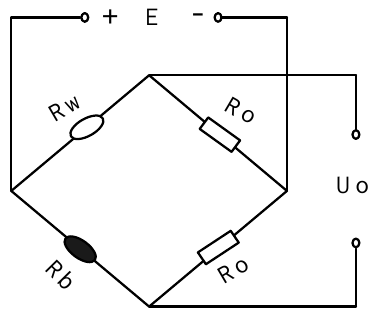
Figure 3. Wheatstone bridge with catalytic